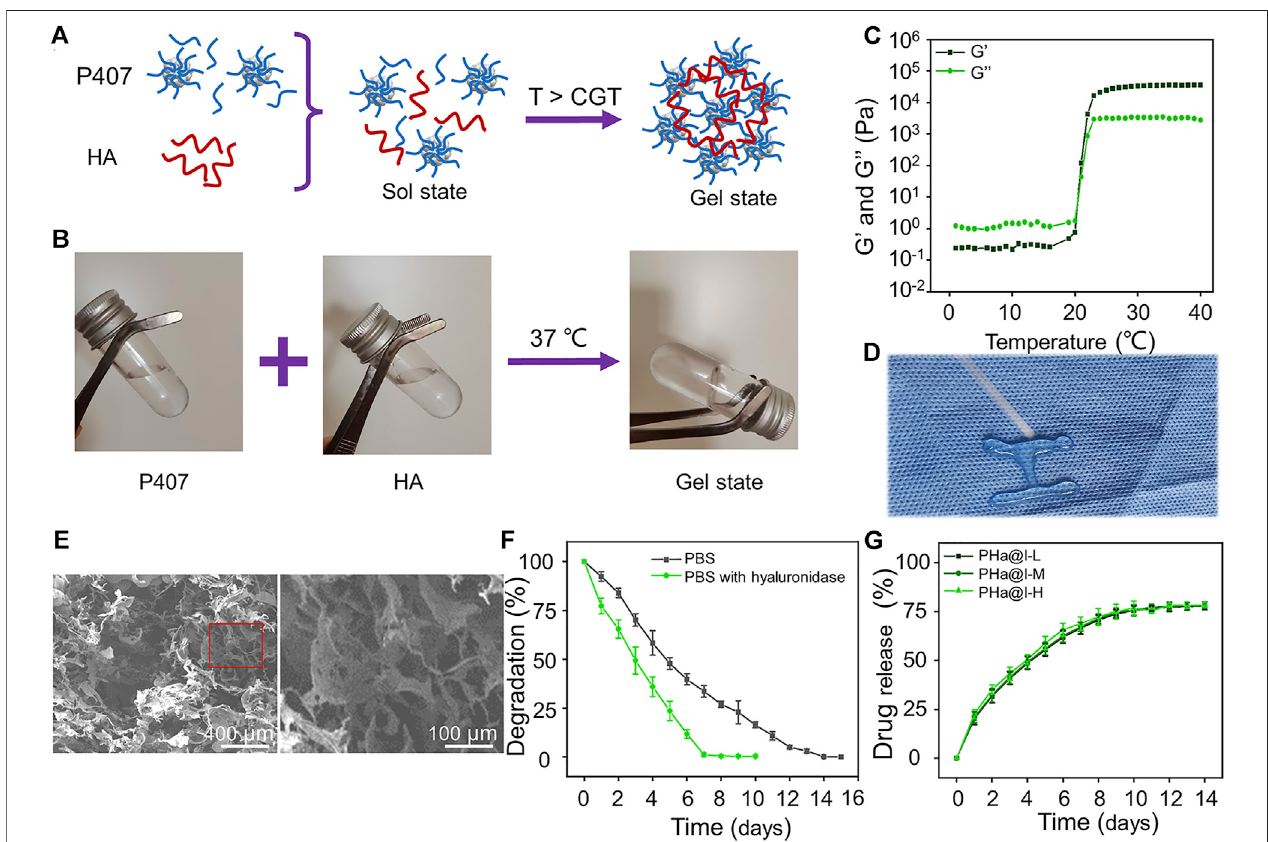
FIGURE 1 | Preparation and characterization of Poloxamer 407 and HA (PHa) hydrogels. (A) Schematic illustration of PHa hydrogel preparation. (B) The optical images of hydrogel sol – gel transition. (C) Storage modulus ( G ′ ) and loss modulus ( G ″ ) of hydrogel as a function of temperature. (D) The injectable and thermosensitive hydrogelrapidlyformgelwheninjectedintoahotplateat37 ° C. (E) MorphologiesofhydrogelobservedbySEM. (F) DegradationrateofthePHahydrogelsinphosphate- buffered saline (PBS) at 37 ° C. (G) Release pro fi le of icariin from the PHa hydrogels in PBS at 37 ° C ( n =